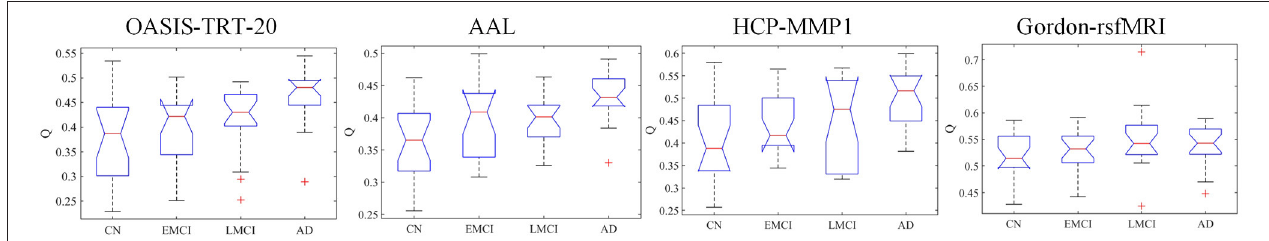
FIGURE 4 | Group median and interquartile ranges of Q coefficient of modularity structure for each group. P -values derived from Kruskal-Wallis tests assessing SC topological differences among NC, EMCI, LMCI, and AD for each parcellation scheme are reported in Table 5 .